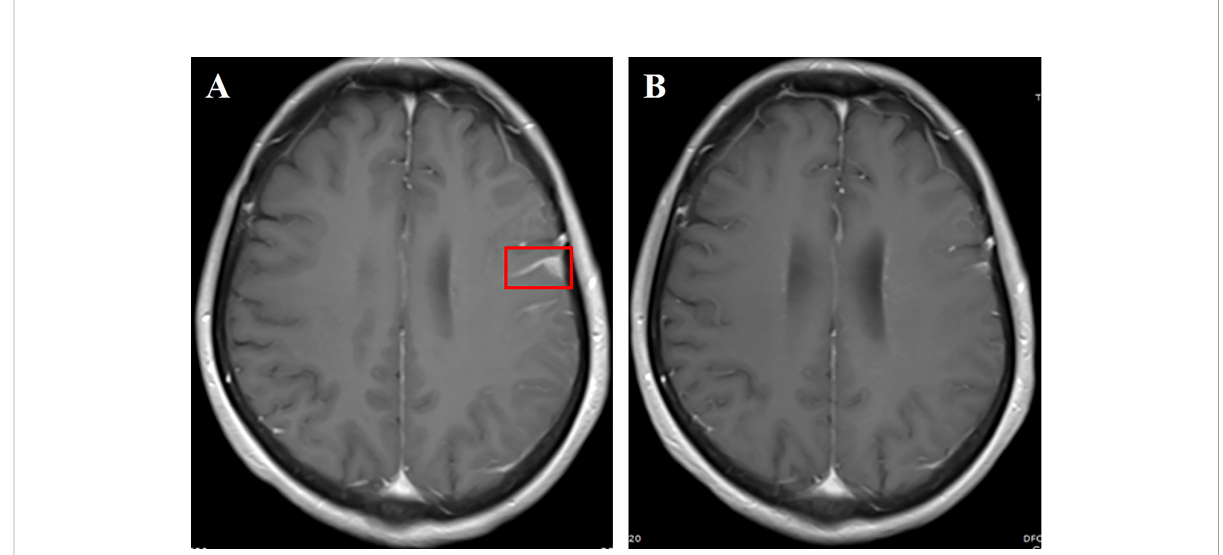
metastatic lesions were revealed by combined results obtained from thoracic and abdominal CT and whole-body bone scan. LM was con fi rmed based on brain MRI and positive CSF cytology. DNA sequencing of the CSF specimen revealed an EGFR mutation (exon 19 deletion) with CDK4 ampli fi cation. Almonertinib (110 mg/day) plus bevacizumab (7.5 mg/kg, 21- day cycle) was administered for 1 month, which resulted